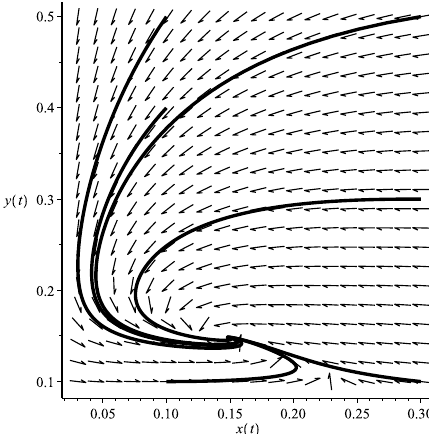
Figure 3: Dynamic behavior of system (5.3), here the initial condition ( x (0), y (0)) = (0.3, 0.5) , (0.3, 0.1) , (0.3, 0.3) , (0.3, 0.4) , (0.3, 0.2) , (0.1, 0.3) , (0.1, 0.1) and (0.1, 0.5) ,